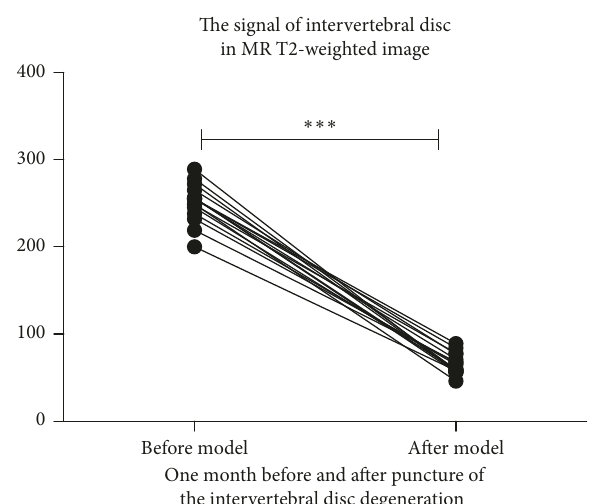
Figure 3: On the 28th day (4weeks) after model establishment, the signal strength of degeneration disc detected by MRI was significantly lower than that detected before the model group ( p